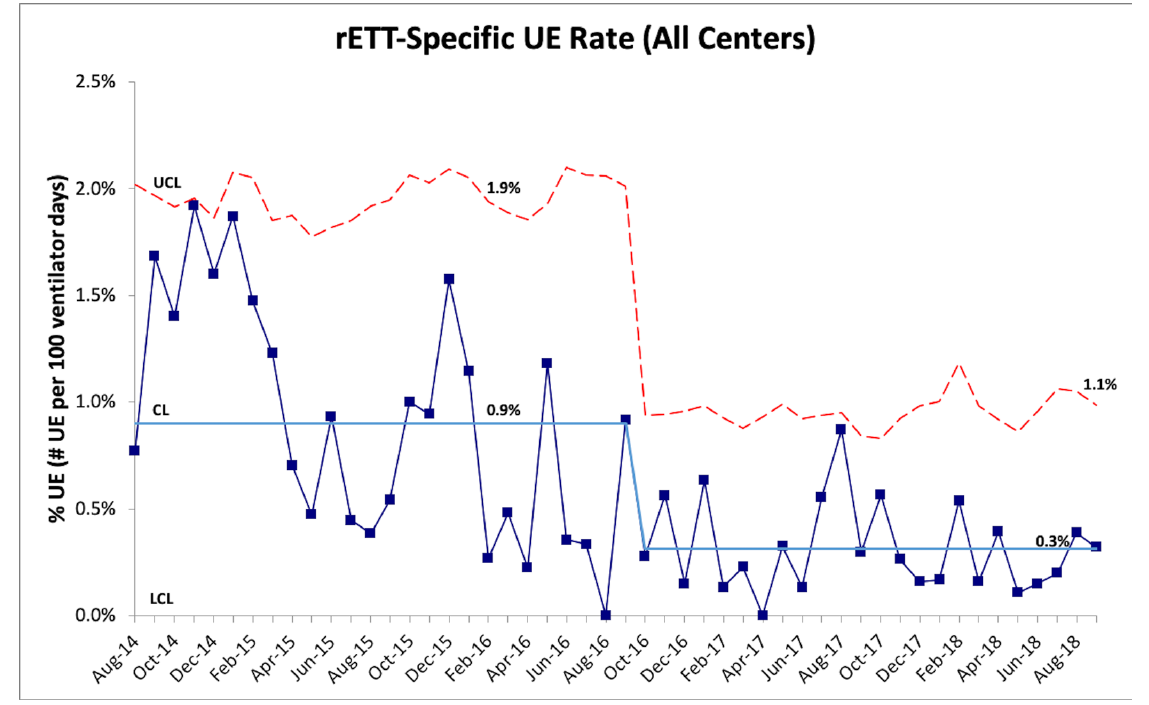
Figure 6. U-chart displaying the combined monthly UE rate for events classified as resulting from a removed ETT (rETT). Special cause variation (rule of shift) was noted beginning in October 2016. CL = center line (mean), UCL = upper control limit, LCL = lower control limit, and ETT = endotra- cheal tube.